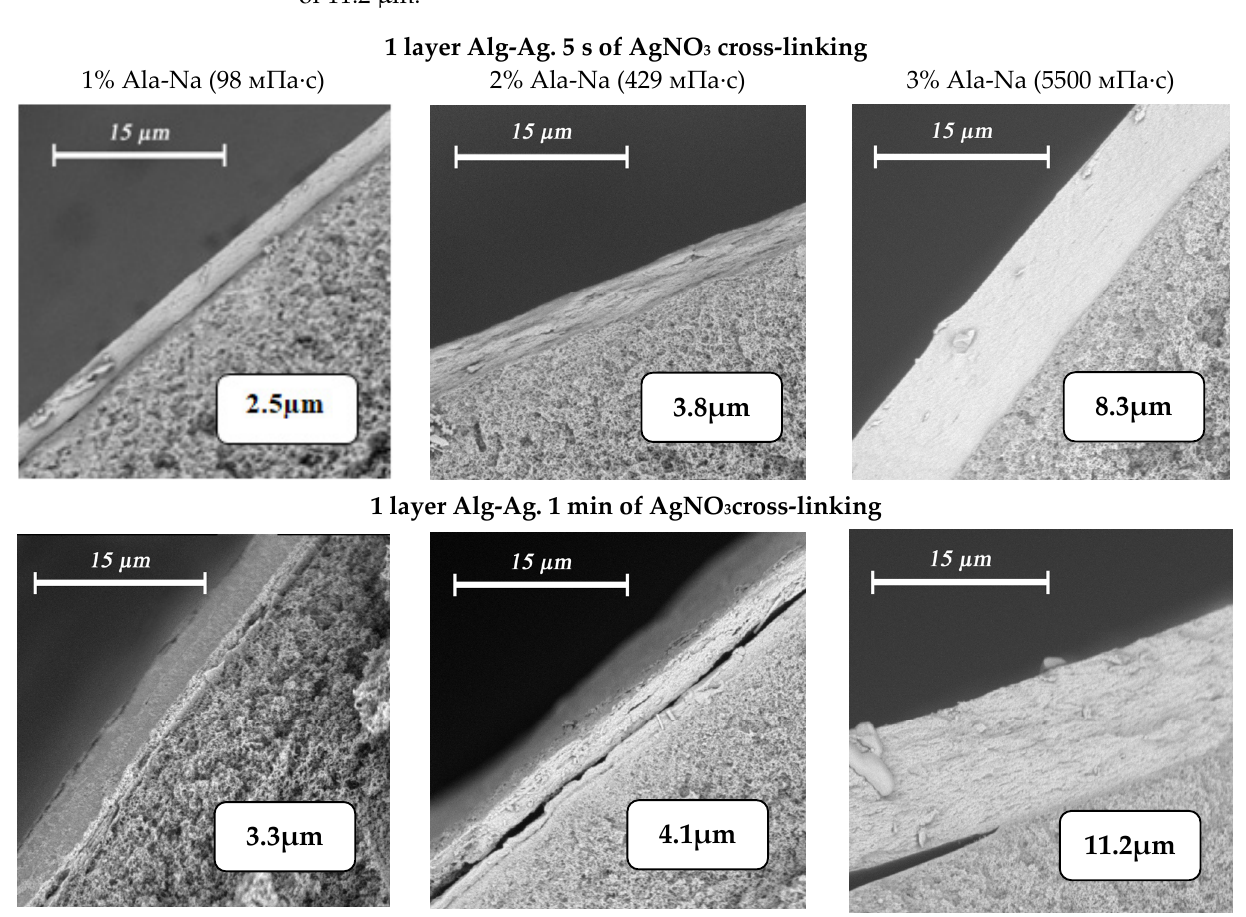
Figure 8. Variation of selective silver alginate layer thickness when varying the alginate concentration (1% wt.—first column, 2% wt.—second column, 3% wt. third column) and crosslinking time of the polymer (one layer—5 s (first row) and 1 min (second row)).